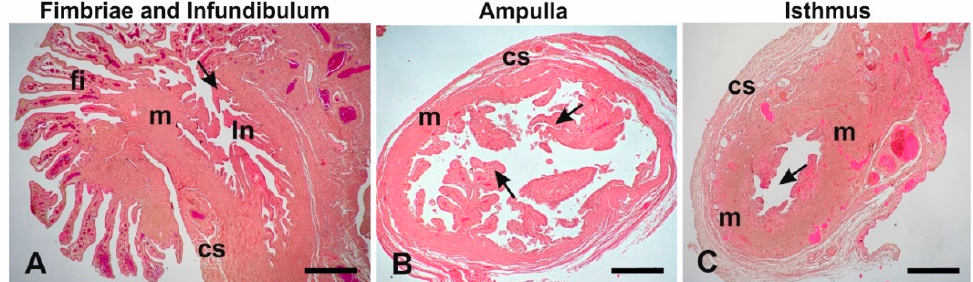
Figure 5. Light micrographs showing the baboon Papio hamadryas oviduct regions at low magnification. ( A ) Fimbriae and infundibulum; ( B ) ampulla; ( C ) isthmus. Key: cs, connective serosa; fi, fimbriae; In, infundibulum; m, muscular wall; arrow, mucosal folds. Hematoxylin-eosin staining. Scale bars: ( A – C ) = 500 µ m.